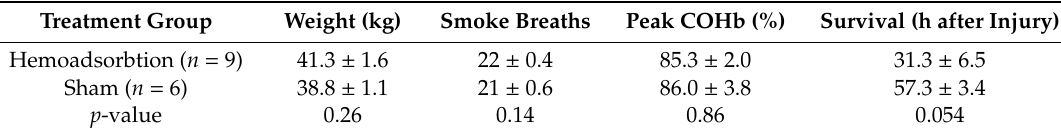
Table 1. Subject data are displayed as mean ± standard error of the